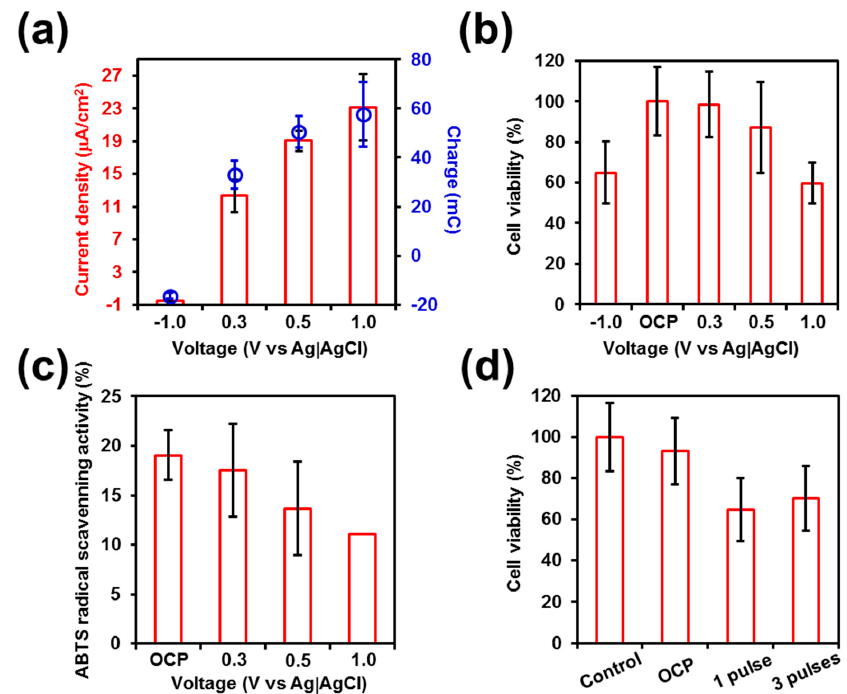
Figure 1. ( a ) Relation between the applied voltage and both the current density (bars) and the accumulated charge (circles). ( b ) Cell viability and ( c ) radical scavenging activity after applying a voltage pulse for 1 min. ( d ) Cell viability after application of one and three pulses of 1.0 V for 1 min (Control and OCP refer to non-stimulated and open circuit potential, respectively). In all cases, cells were cultured on stainless pins (0.5 × 1.0 cm 2 ) within a tissue well-plate (20 × 10 3 cells / well) for 24 h. After this time, pins were used as working electrodes and pulses were applied at the desired voltage for 1 min. Finally, the pins were placed in a new tissue well-plate for 24 h before the MTT and ABTS assays were performed. Each data point corresponds to the average of three samples and the error bars refer to the respective standard deviation.